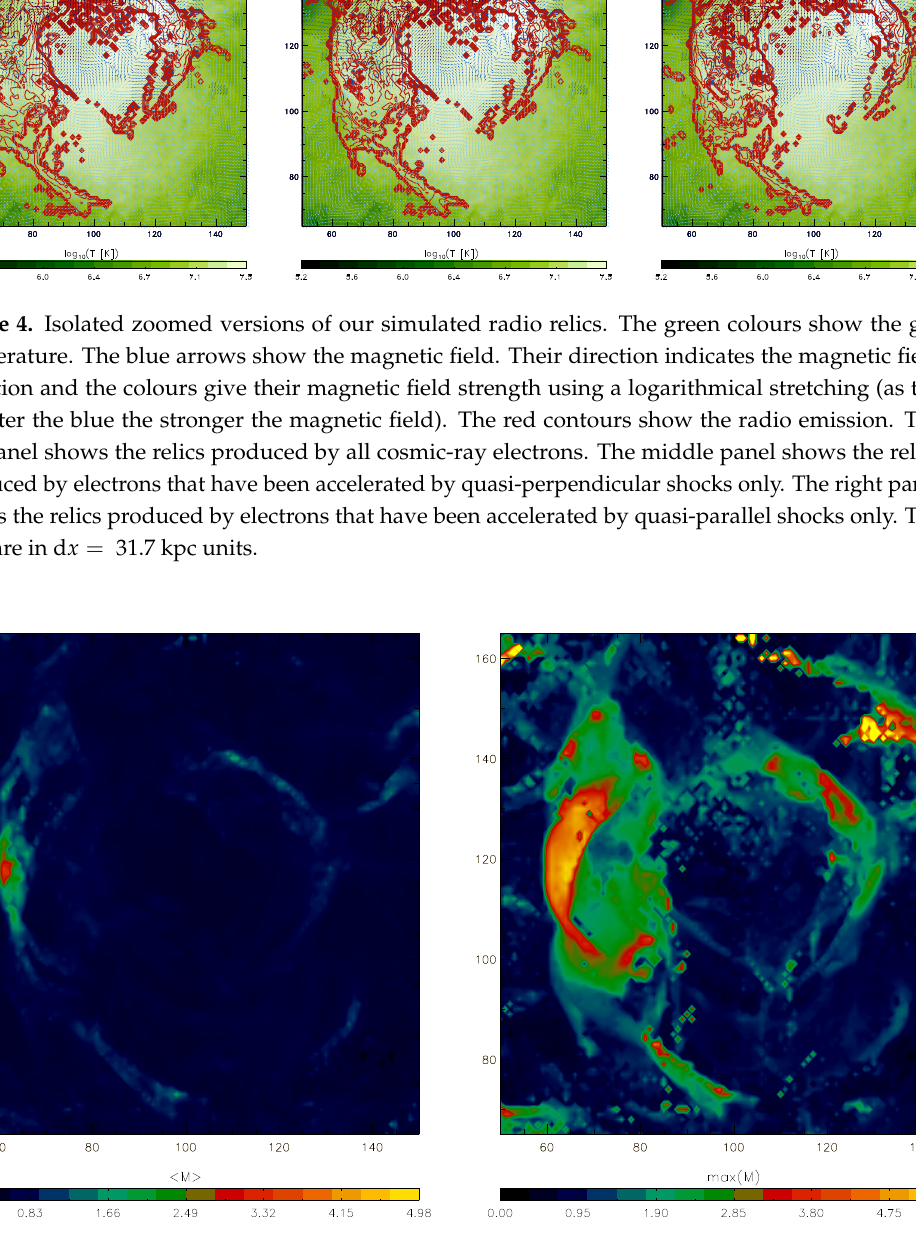
Figure 5. Maps of the mean ( left panel) and maximum ( right panel) Mach numbers of the shocks that are producing the radio relics. The axes are in d x = 31.7 kpc